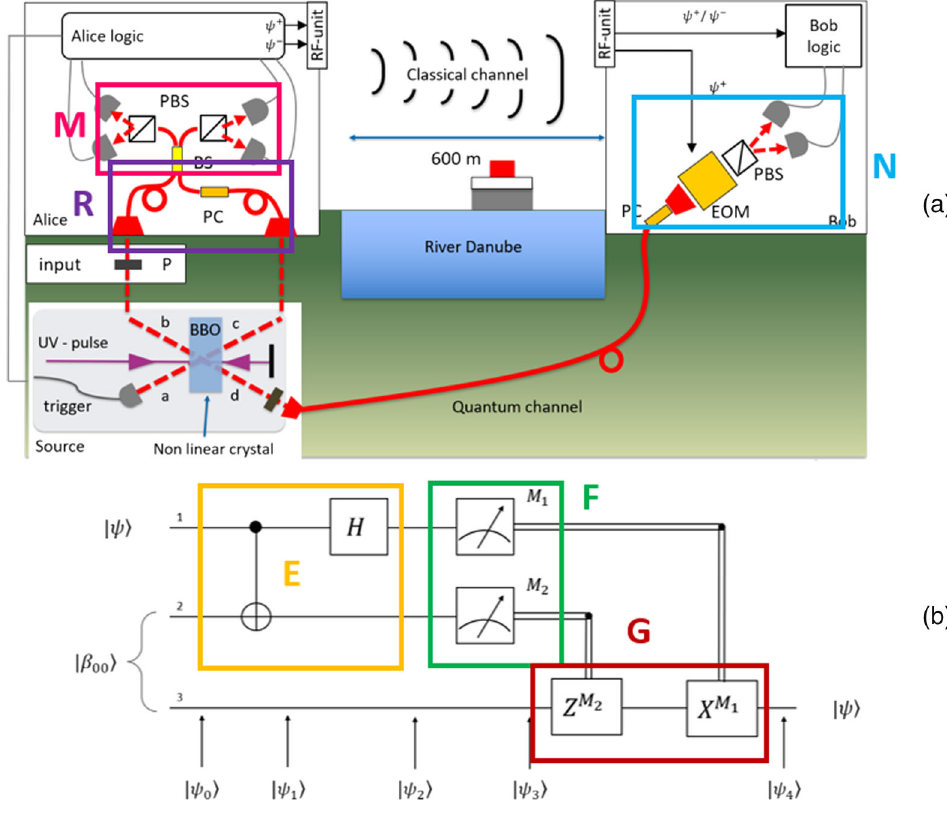
FIG. 27. Experiment and circuit in comparison.